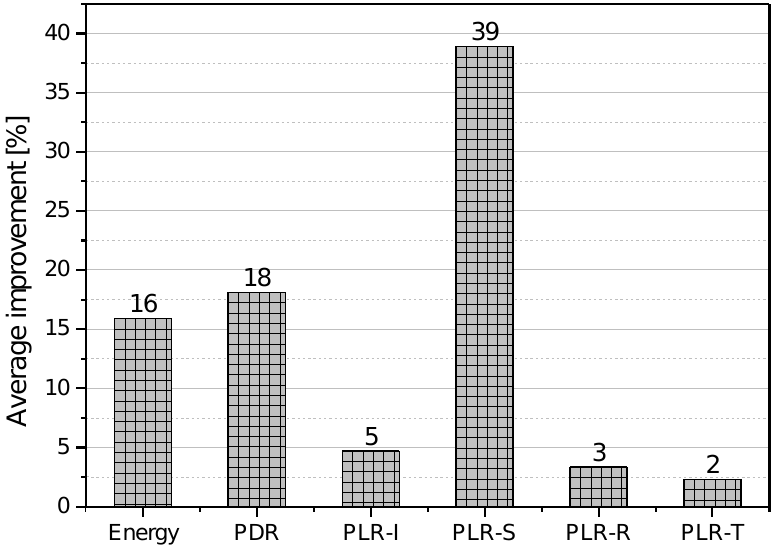
Figure 7. Performance Improvement in Percentage for the Proposed